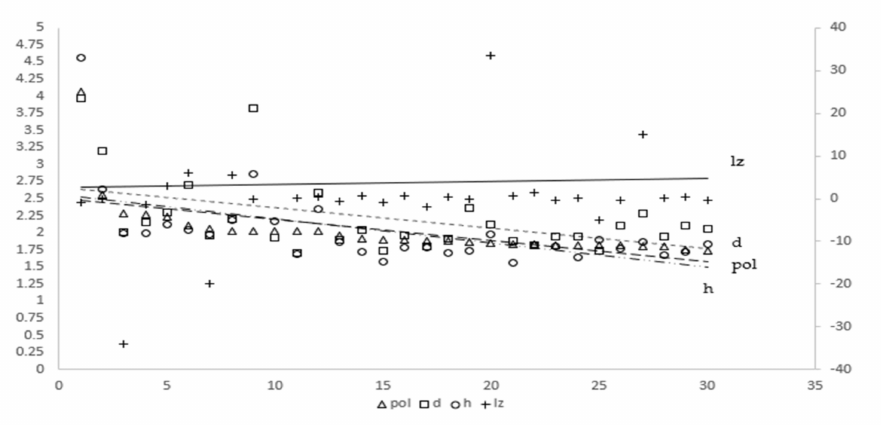
Figure 6. The annual average value and trend of several index measurement results in various provinces. Note: The serial numbers 1–30 on the x-axis represent Shanghai, Tianjin, Hebei,